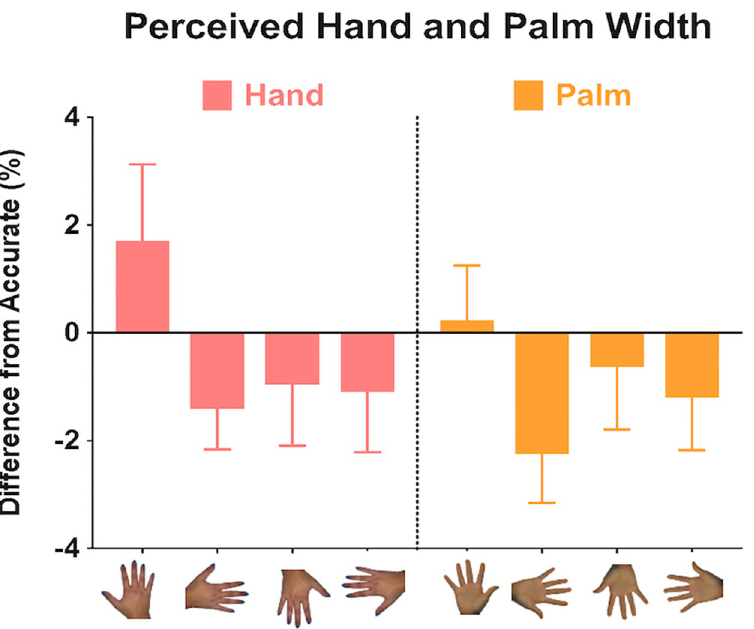
Fig 2. Perceived width of the dorsum and palm. Mean differences from accurate when dorsum of the hand (left panel) or palm (right panel) was distorted in the width dimension for each viewing orientation. Positive and negative scores represent overestimation and underestimation respectively. Error bars represent ± 1